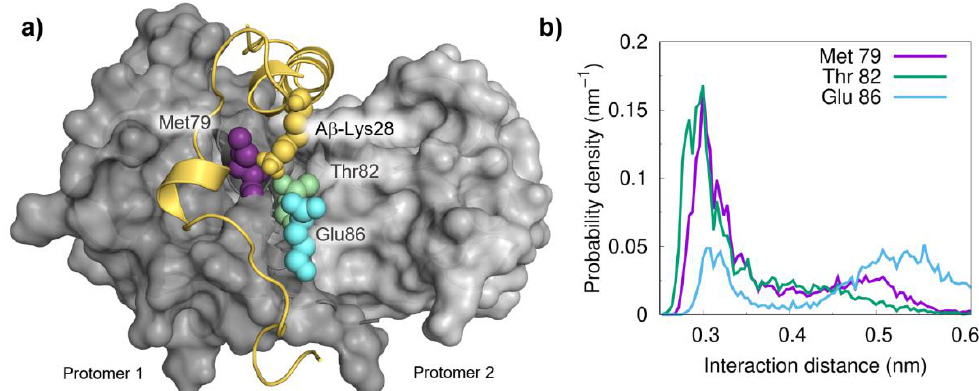
Figure 3. Mapping the interactions of Lys28 from Aβ42 with S100B residues. ( a ) Structural representation of the Aβ 42 :S100B complex highlighting the important role of Lys28 (yellow) and distances to nearby residues Met79 (pink, 0.74 nm), Thr82 (green, 0.37 nm) and Glu (blue, 0.58 nm). ( b ) Probability density distributions of minimum distances between Lys28 (the terminal amino group) and the hot spot partner residues on the S100B surface.